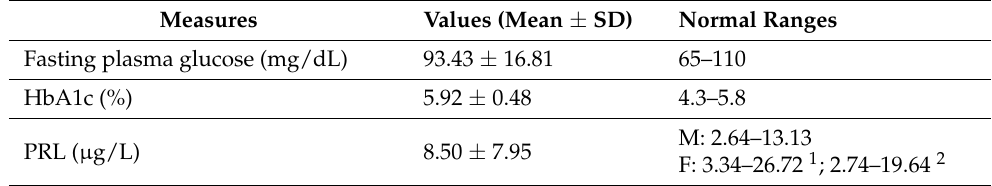
Table 2. Main hormonal and biochemical parameters investigated in acromegalic